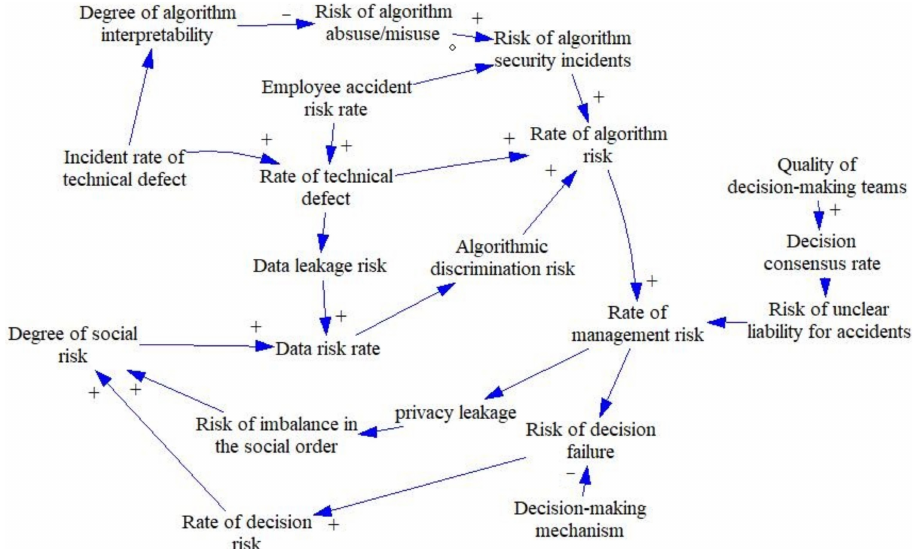
Figure 5. Risk subsystem causality diagram. Loop 1: degree of social risk (DSR) → data risk rate (DRR) → algorithmic discrimination risk (ADR) → rate of algorithm risk (RAR) → rate of management risk (RMR) → risk of decision failure (RDF) → rate of decision risk (RDR) → degree of social risk (DSR); Loop 2: DSR → DRR → ADR → RAR → RAR → privacy leakage (PL) → risk of imbalance in the social order (RISO) → DSR.